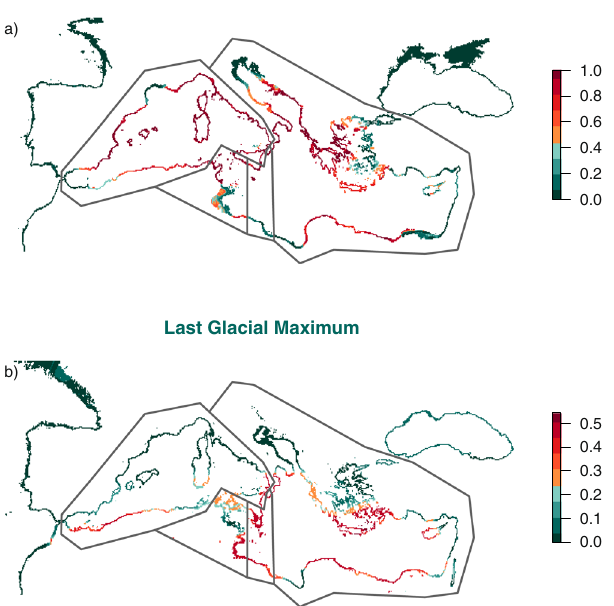
Figure 2. Distribution of Posidonia oceanica predicted by ensembles under current ( a ) and Last Glacial Maximum (LGM) conditions ( b ). A major probability of occurrence is predicted in the Western and Northern Mediterranean Sea for the present. Three putative glacial refugia, located in the Southern Mediterranean, were found by hindcasting to the LGM. Divisions correspond to genetic regions identified in the Mediterranean Sea by ref. 15 and ref. 17. Maps were generated using R 43 .